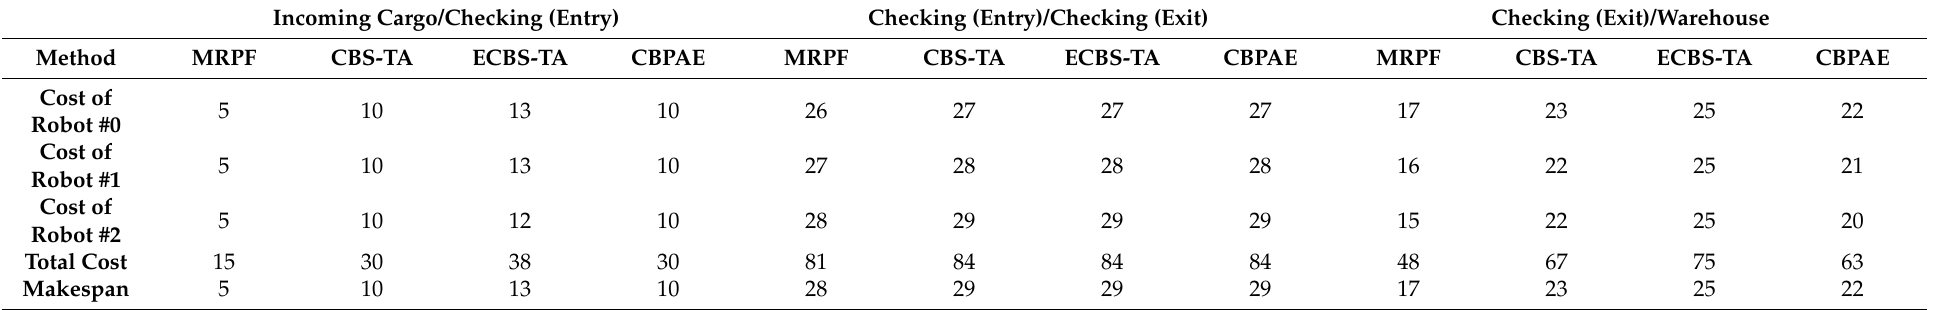
Table 9. Comparison of the MRPF approach with other works for the tasks of the Incoming Cargo process.